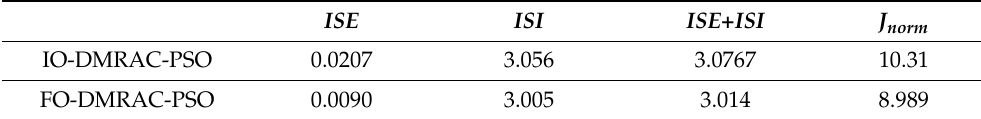
Table 5. J norm cost function using optimization by PSO for IO-DMRAC and FO-DMRAC.